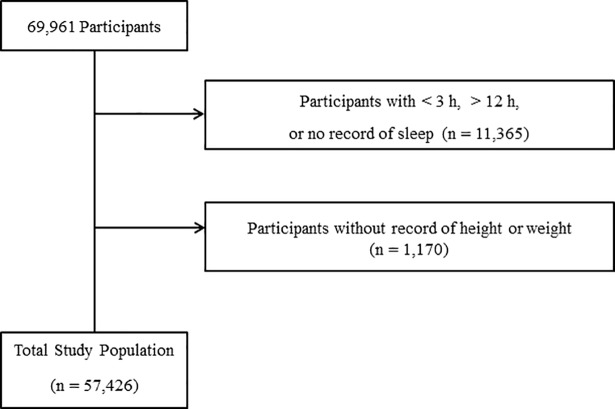
A schematic illustration of participant selection in the present study.Among a total of 69,961 participants, participants without information on sleep time or who sleep less than 2 h (11,365) and those without height or weight data (1,170) were excluded. Complete data for 57,426 participants were obtained and analyzed.